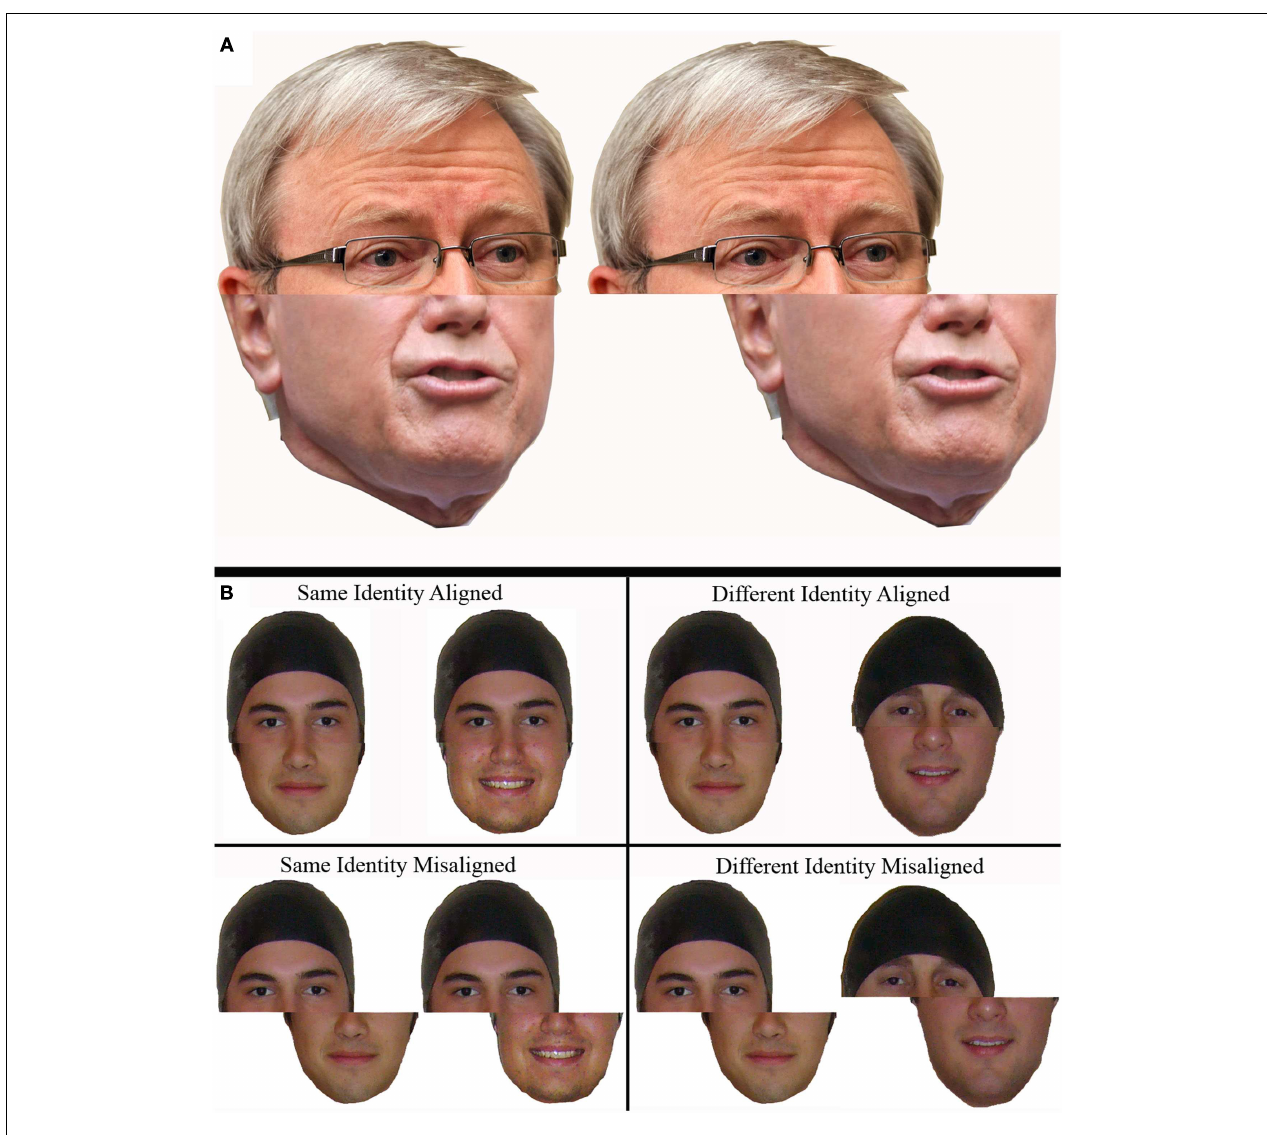
example the top half belongs to Kevin Rudd and the bottom half belongs to John Howard (both former Prime Ministers of Australia). (B) The same/different version using unfamiliar faces (where the top half is the